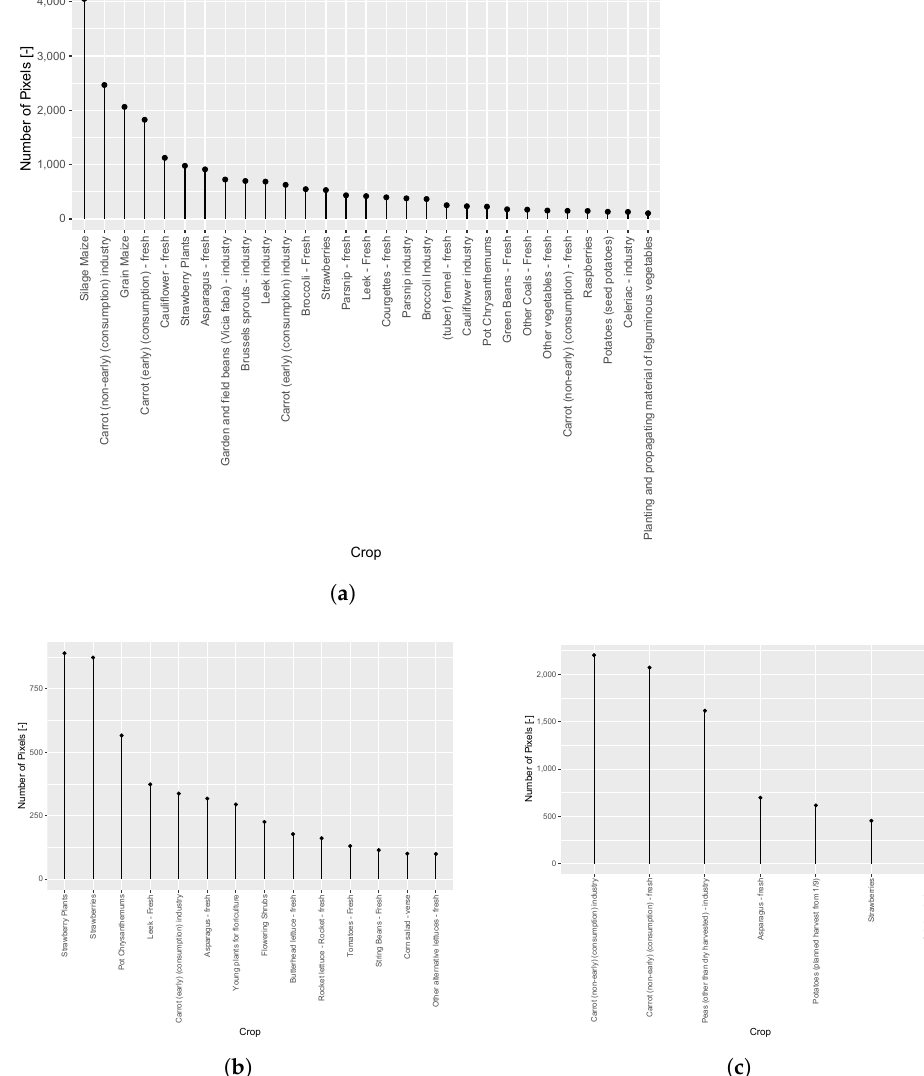
Figure 15. Attributed pixels to various types of artificial covers and their corresponding crops (data acquisition is 20 April 2020—Rank 1). ( a ) Temporary covers. ( b ) Non-plastic greenhouses. ( c ) Plastic